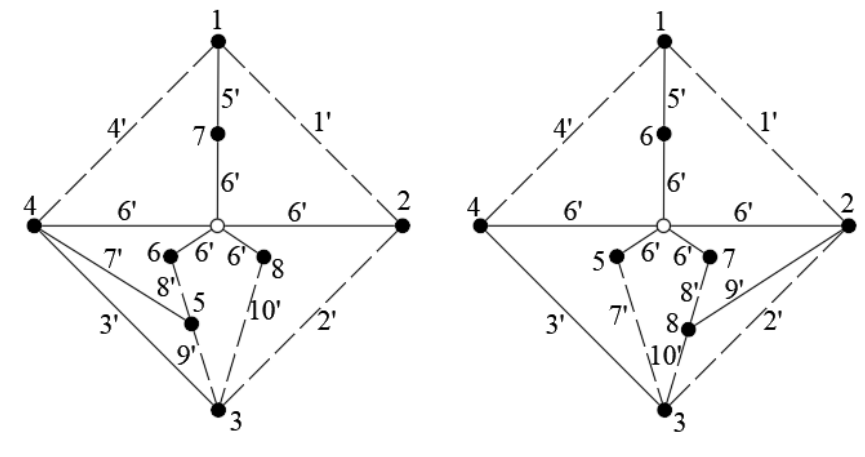
Figure 4. The topological graphs of 10-link EGTs b 1 and b 2